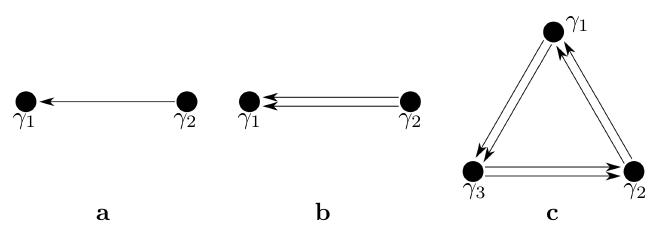
Figure 5 . BPS quivers of a: AD (Kronecker quiver), c: